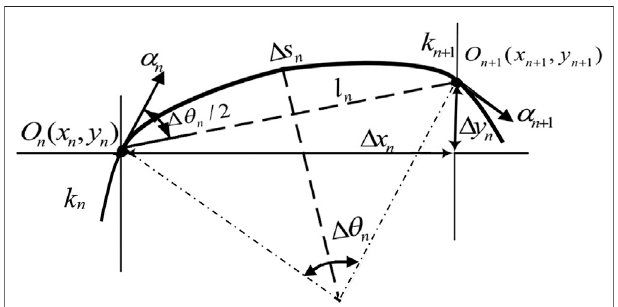
FIGURE 3 | Schematic diagram of the curve reconstruction algorithm.